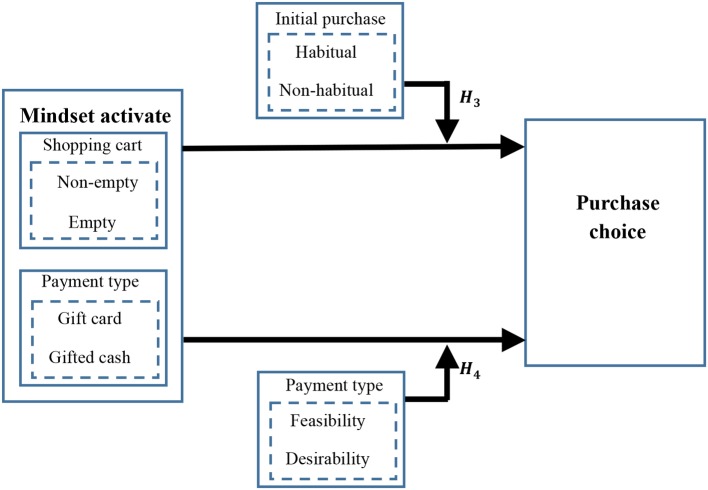
Moderating model.